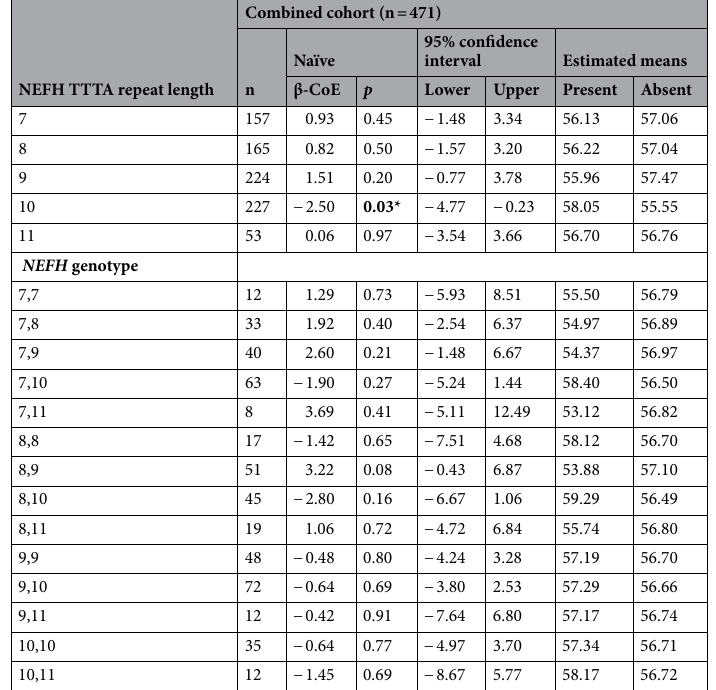
Table 4. Naïve generalized linear model evaluating the association between NEFH TTTA alleles/genotypes and age of disease onset in the combined sALS cohort. The following genotype were excluded form analysis due to low frequency: 6,7; 8,12; 9,15; 10,13; 11,11. Values in bold with * denote statistical significance p <